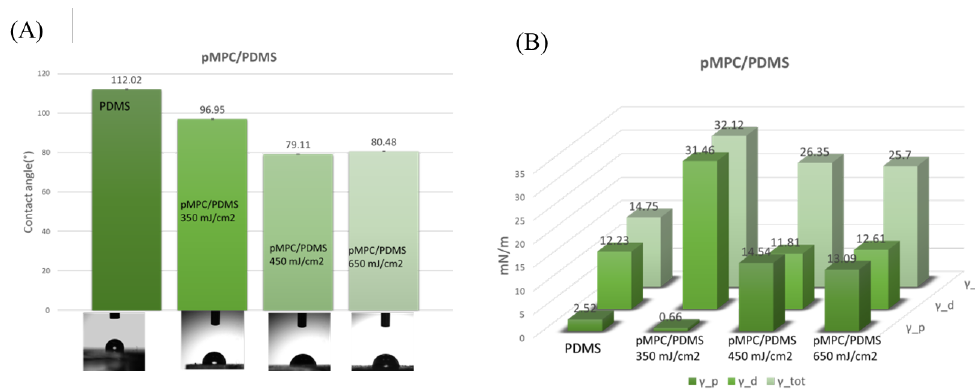
Figure 8. Histograms of contact angle measurements onto PDMS and pMPC coatings onto untreated PDMS ( A ), and the corresponding surface energy ( B ).